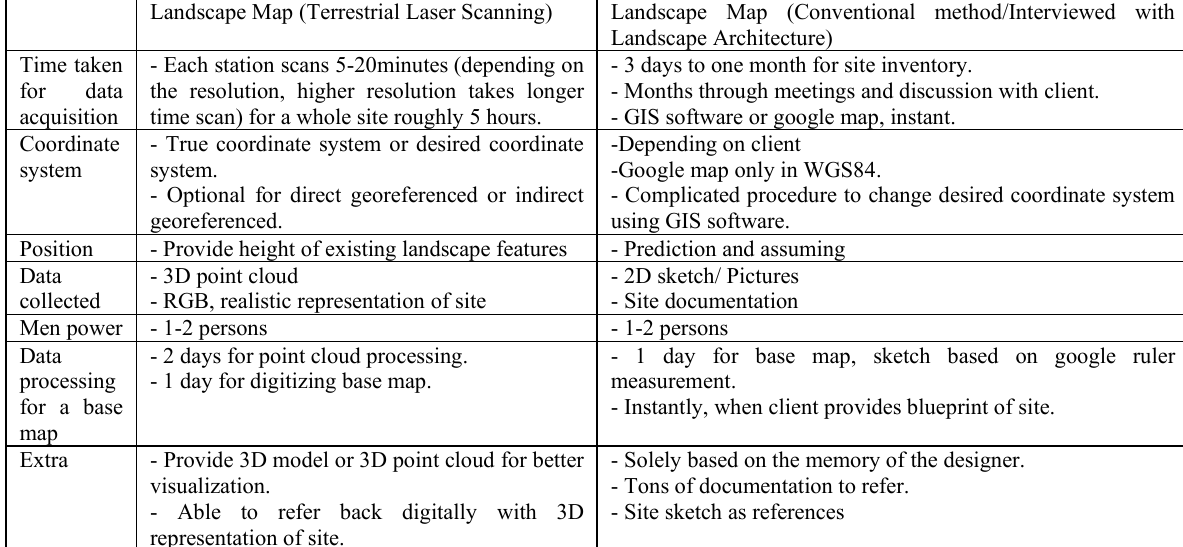
Table 3.5 Comparison between landscape (TLS) and Landscape (Conventional method/Interviewed with Landscape Architecture) Landscape Map (Terrestrial Laser Scanning) Landscape Map (Conventional method/Interviewed with Landscape